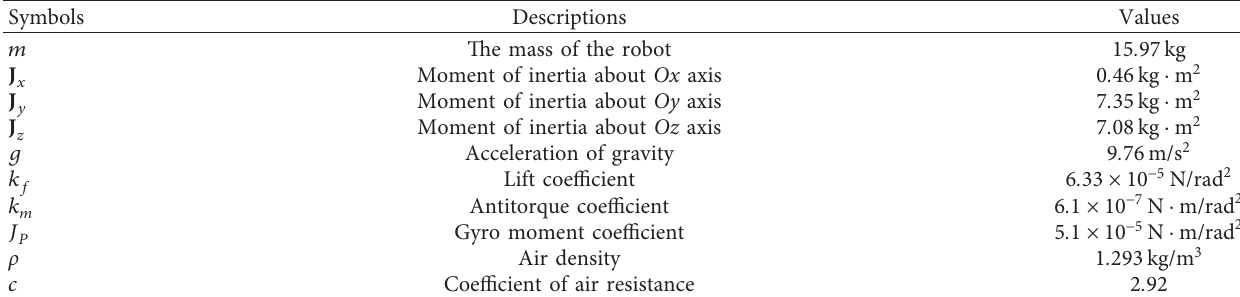
Table 1: Simulation parameters of the tree-pruning robot system. Symbols